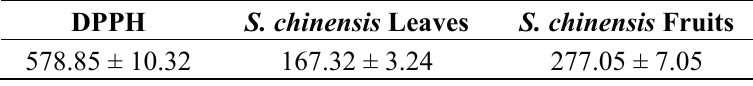
Table 4. The values of integral intensities for the analyzed